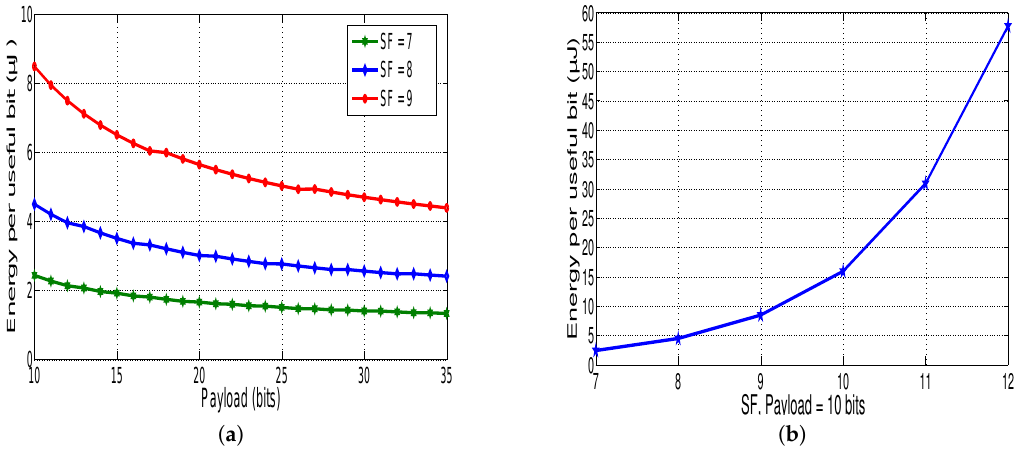
Figure 9. ( a ) Effect of SF on the consumed energy, CR = 4 function of SF